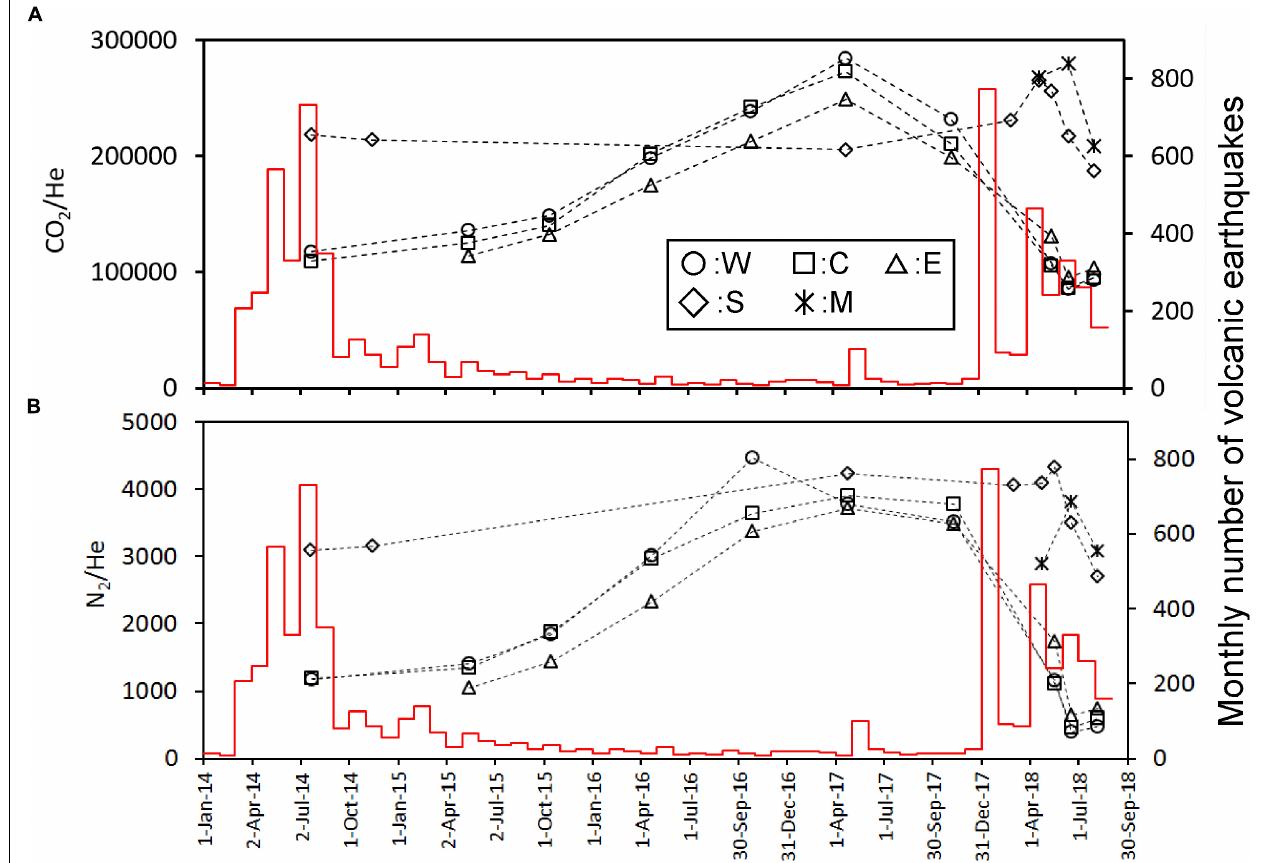
FIGURE 6 | Time variation of CO 2 /He (A) , N 2 /He (B) molar ratios calibrated on the left y -axis. The red histogram calibrated on the right y -axis shows the monthly number of volcanic earthquakes observed by